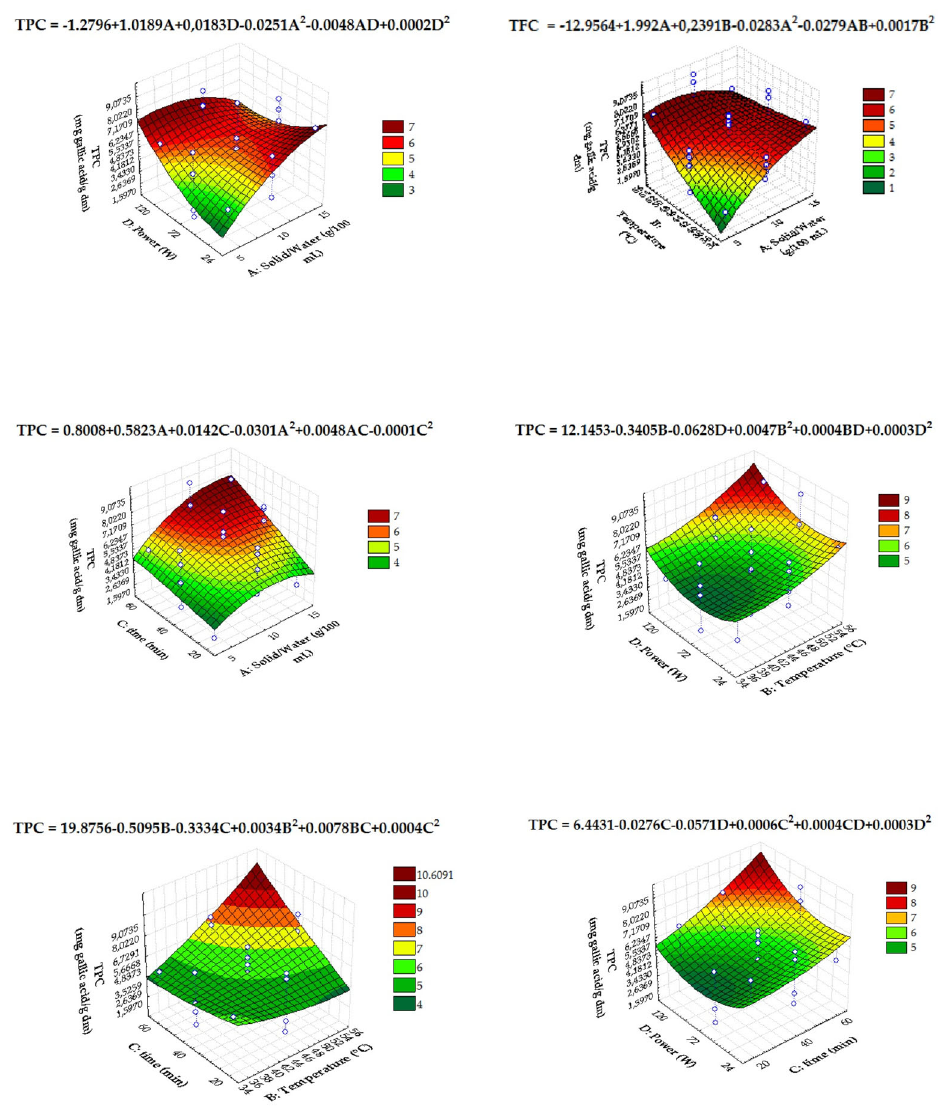
Figure 1. Three-dimensional response surface plots for TPC (mg gallic acid/g dm) of chicory extracts obtained through UAE: effect of solid–water ratio (A), temperature (B), extraction time (C), power (D), and their interactions.